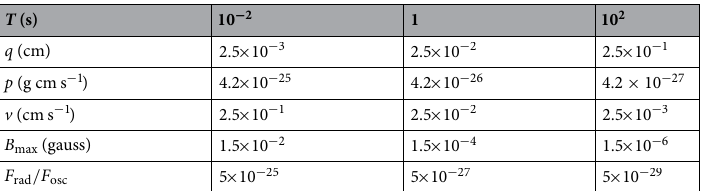
0.43 and (cid:31) y 1.125 Table 1. Physical conditions (in cgs) to achieve the squeezing transformations (cid:31) x = − = − on a proton moving inside a cylindrical solenoid. The reported quantities have been calculated regarding the x y and p p x p y correspond to the example in Fig. 4. The physical magnitudes of q , p and v , with q = = = = 1 according to Eq. (6). Note how the incredibly modest strength p y p dimensionless values x ′ ′ y = ′ = ′ x = = of the magnetic field grows as the operation time T becomes shorter, to form an idea, a control operation 2 10 of T s. would require half the strength of Earth’s magnetic field on the equator. In the last row it is − = reported the average ratio of the Abraham-Lorentz radiative force to the time-dependent oscillator forces, at different operation intervals T